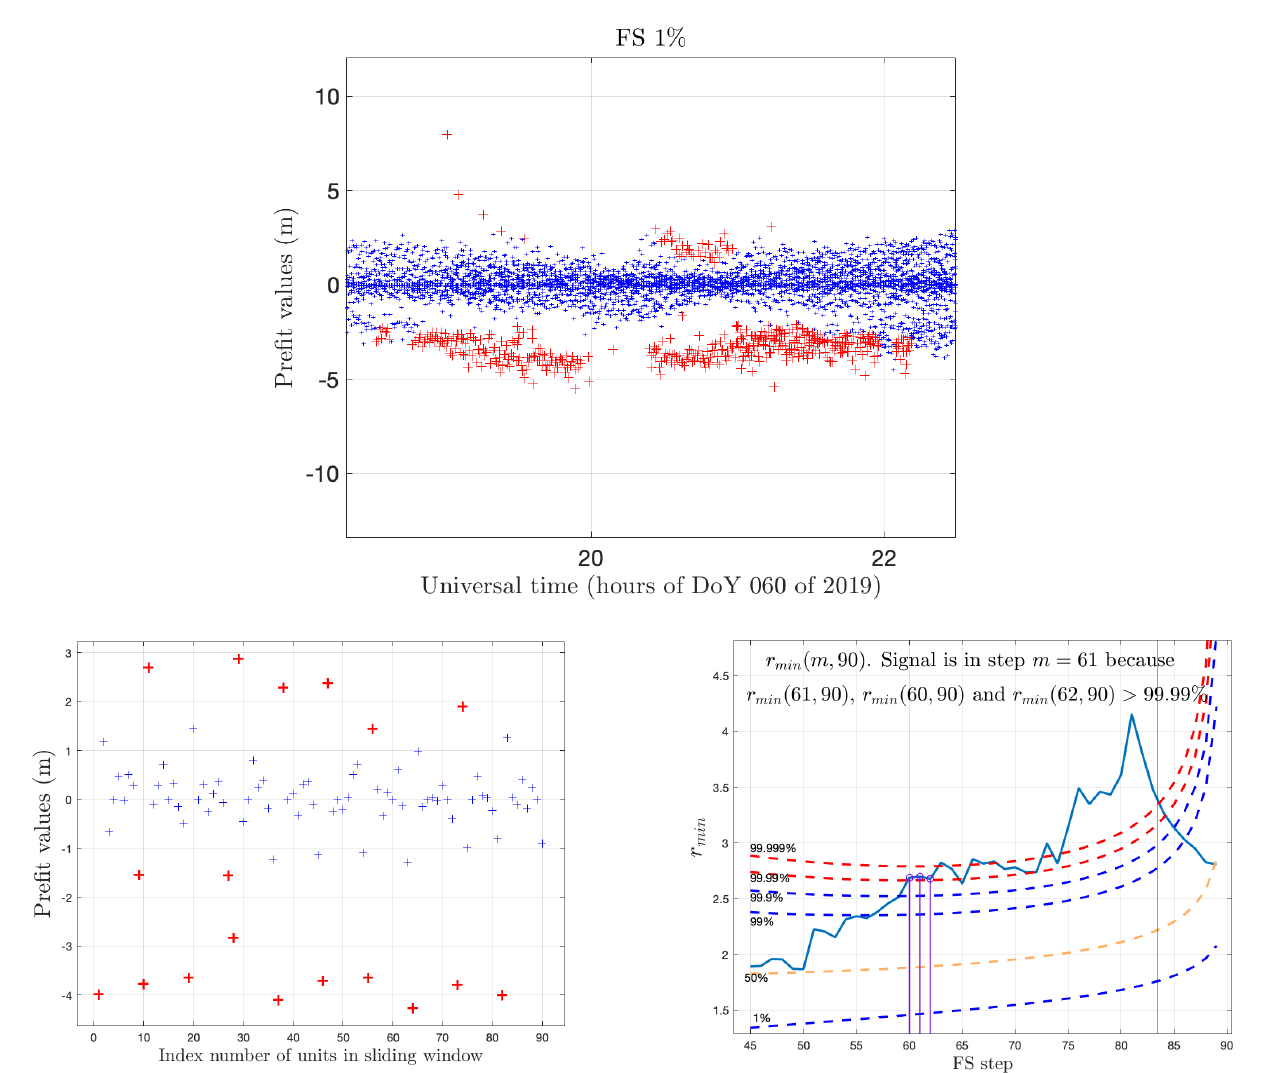
Figure 10. The FS outlier detection mechanism. The top panel enlarges Figure 4 (third row, first column) in an interesting zone between hours 19 and 22, where three somewhat deviating satellites were detected as outliers. The zone refers to the window of 10 epochs starting at iteration 2470 of 2879, that is at time 20 h 34 m . The bottom-left panel shows the n = 90 observations (9 satellites for 10 epochs) monitored in that zone; here, the x axis tick marks are unique observation identifiers (index-numbers) not necessarily ordered in time: they refer to the random order the satellites enter in the sliding window. The red crosses were detected as outliers by the FS, whose progress is shown on the right panel; the x axis ticks of the right panel refer in fact to the FS